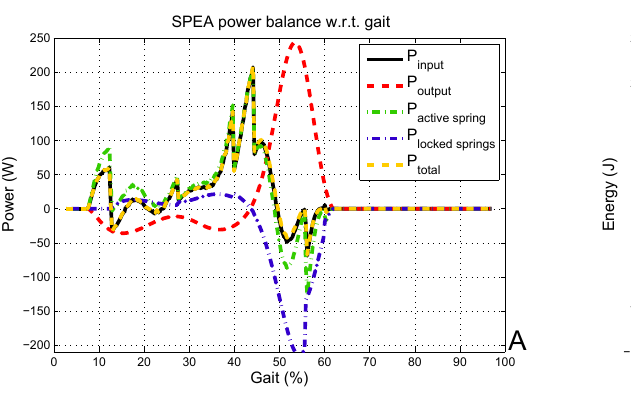
Figure 7. The power and energy equilibrium of the SPEA are shown in (A) and (B). The motor peak power, P , has a short peak at 200 W and one at 150 W. Besides both peaks, input the motor power is always lower than 100